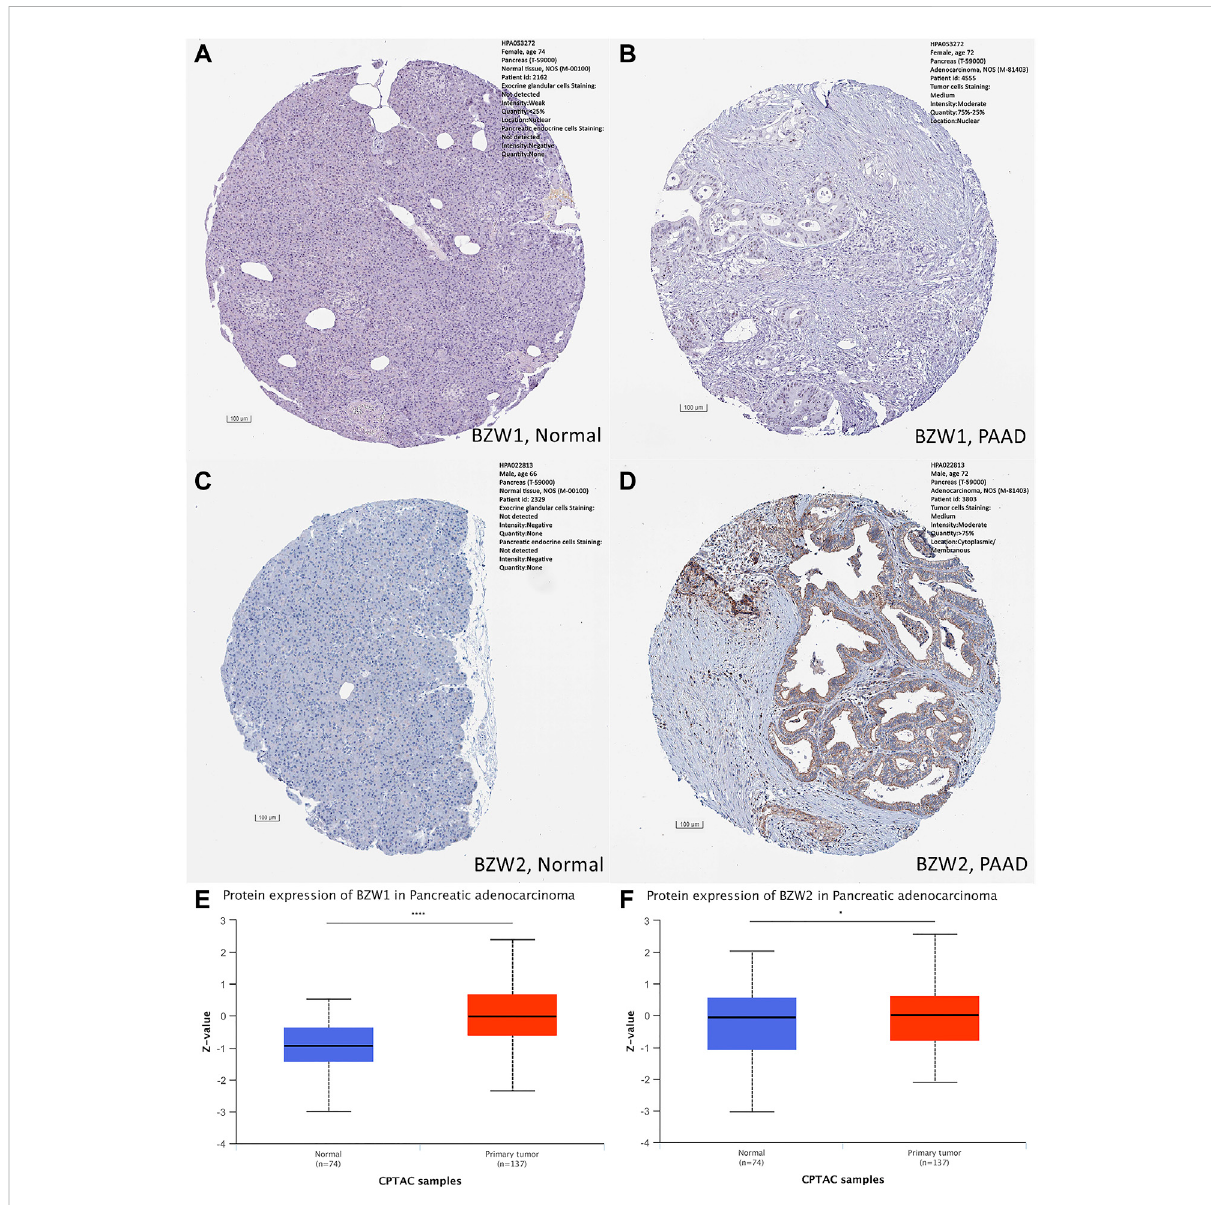
FIGURE 2 Immunohistochemistry staining in normal and PAAD tissues, respectively. Compared to normal tissues, the expression levels of BZW1 and BZW2 were upregulated in PAAD tissues (A,B,C,D) . Compared to normal tissues, expression levels of BZW1 (E) and BZW2 (F) proteins were signi fi cantly higher in PAAD tissues based on CATAC